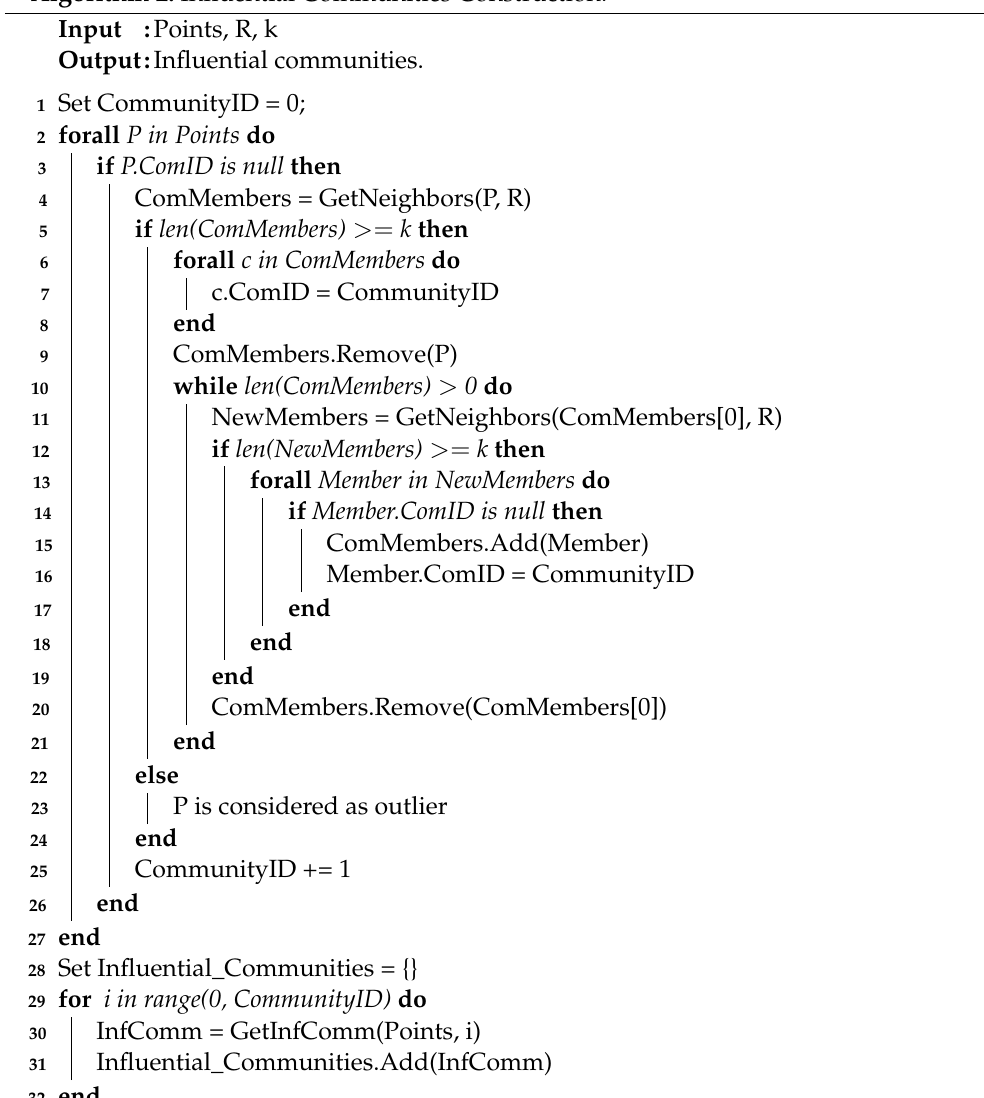
Algorithm 2: Influential Communities